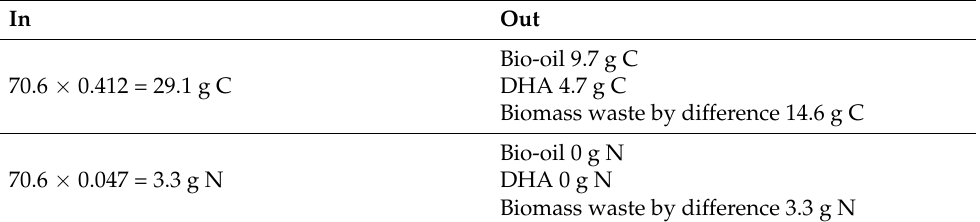
Table 2. Mass balances for carbon and